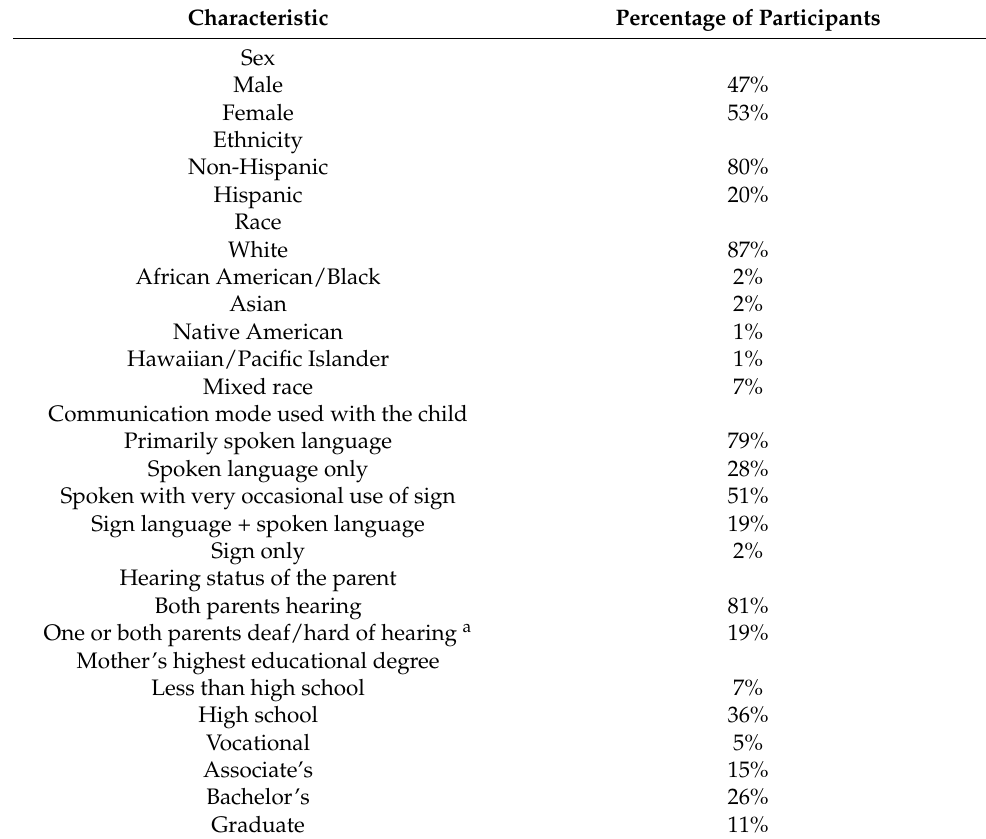
Table 1. Participant and Family Demographic Characteristics.